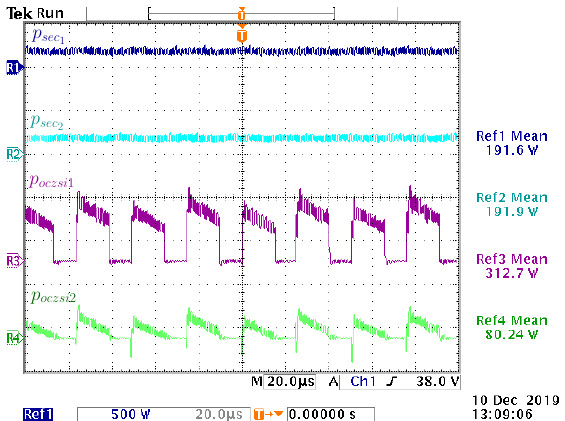
Figure 15. Multiport power imbalance test. Ch1 (500 W/div): output power in secondary port 1 p sec Ch2 (500 W/div): output power in secondary port 2 p sec module 1 p oczsi , and output power in CZSI module 2 Ch4 (500 W/div): p oczsi 1